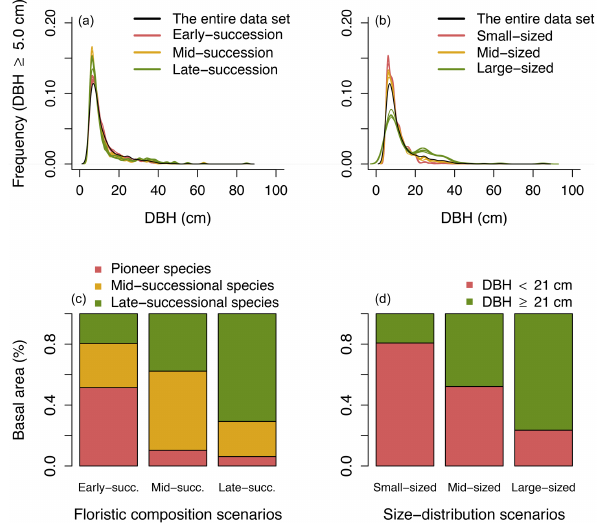
Figure 2. Sampling schemes applied to assemble the six forest scenarios designed to reflect changes in floristic composition and size distribution of trees, typical of central Amazonian terra firme